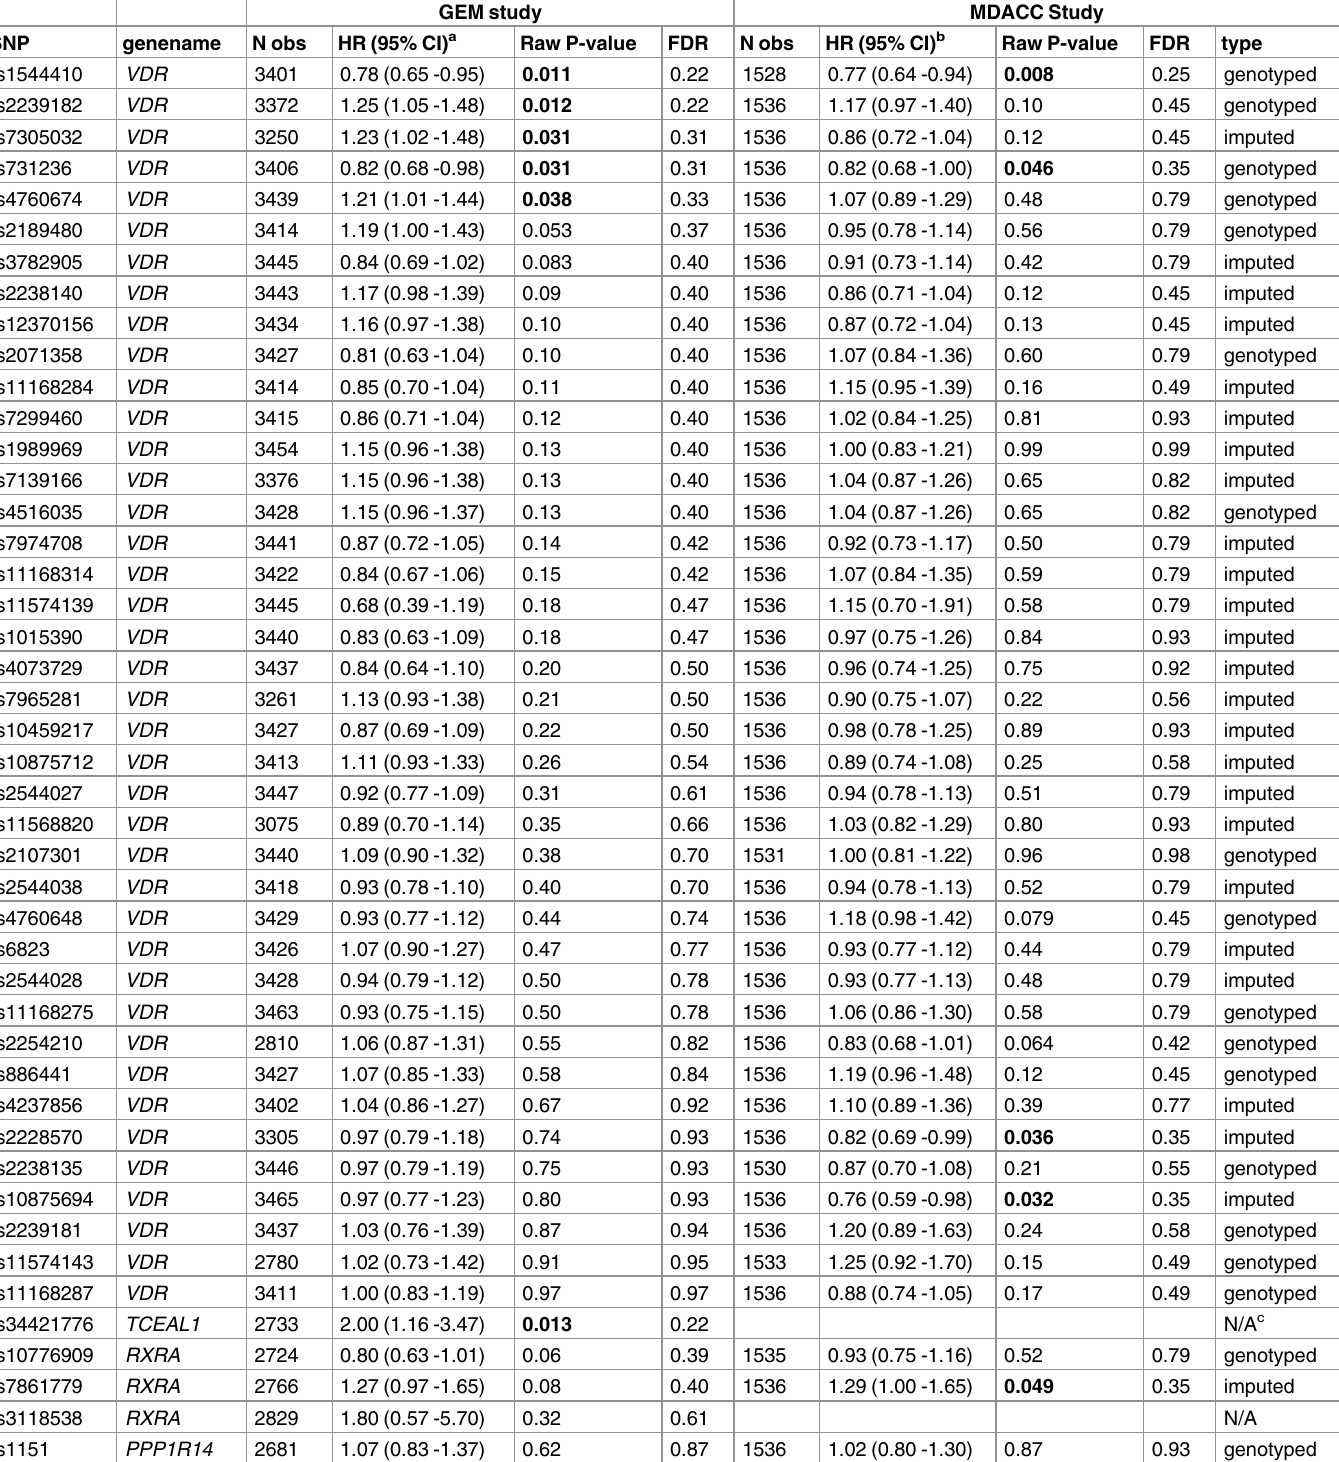
Table 4. The association between SNPs and melanoma specific survival identified by Cox proportional hazard regression model in the GEM study and MD Anderson study before and after the FDR correction. GEM study MDACC